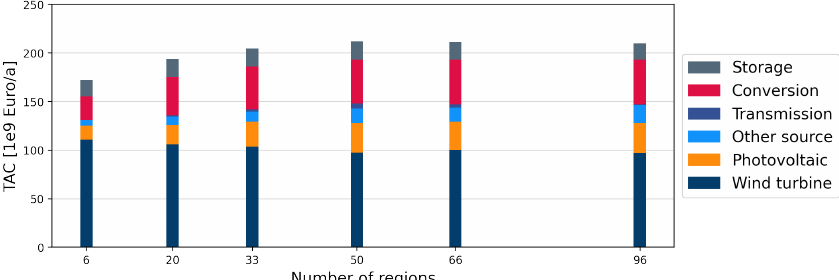
Figure 10. TAC obtained for different technologies in the case of differing numbers of aggregated regions, while considering 68 VRES time series per